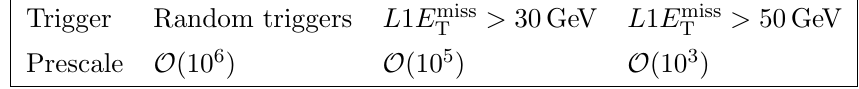
Table 1. Triggers used for comparing the cell E miss